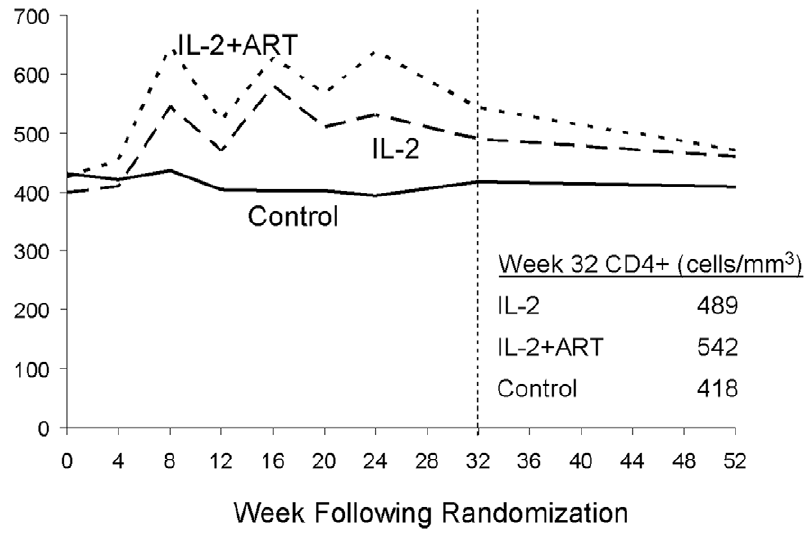
Figure 2. Median CD4 + cell count.